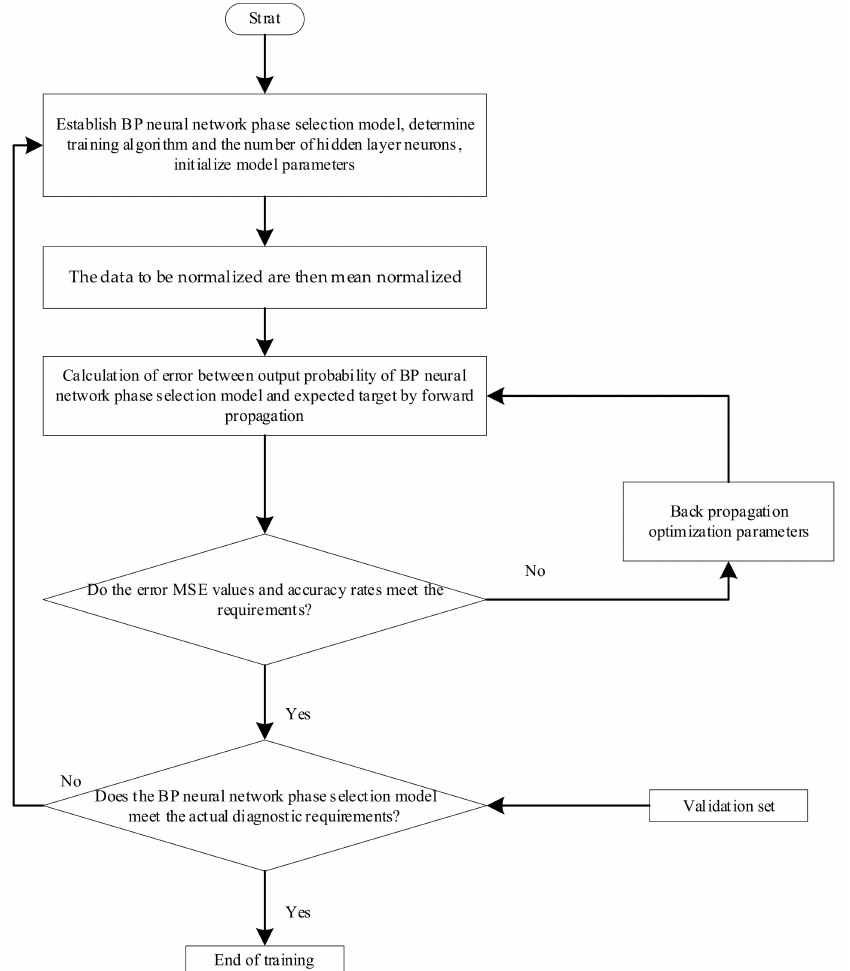
Figure 4. Stator ground fault phase selection algorithm flow chart based on BP neural